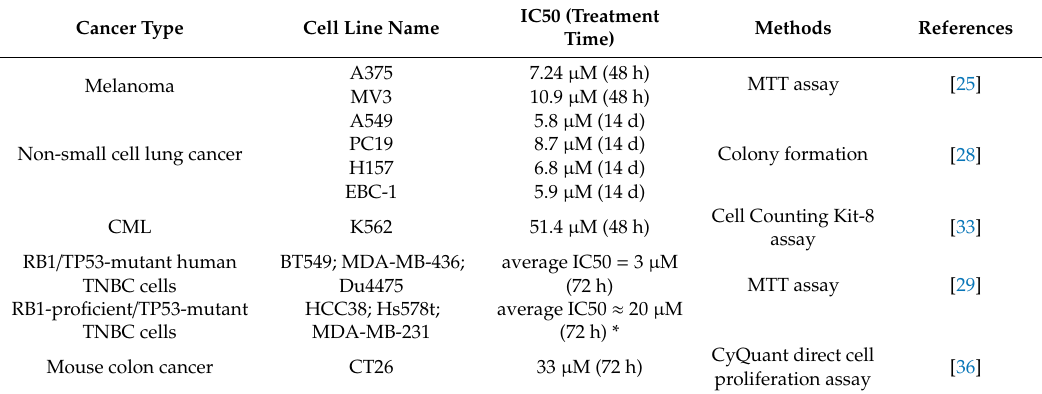
Table 1. IC50 of tigecycline in several types of tumor cells. Please note that direct comparison of the IC50 data is not straightforward since obtained in different conditions with different methods.